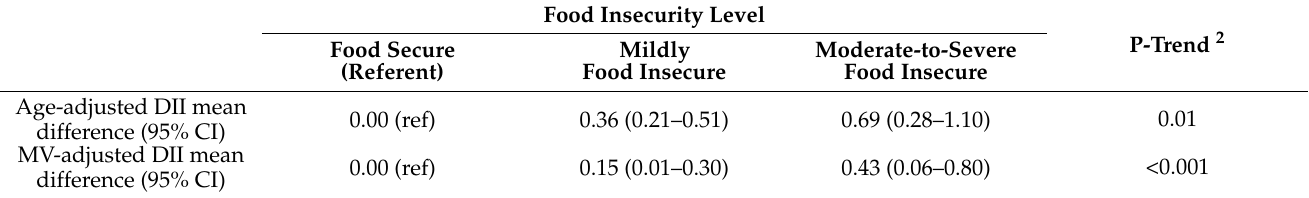
Table 2. Age-adjusted and multivariable-adjusted 1 mean differences of dietary inflammatory index (DII) (95% confidence interval) according to food insecurity levels.